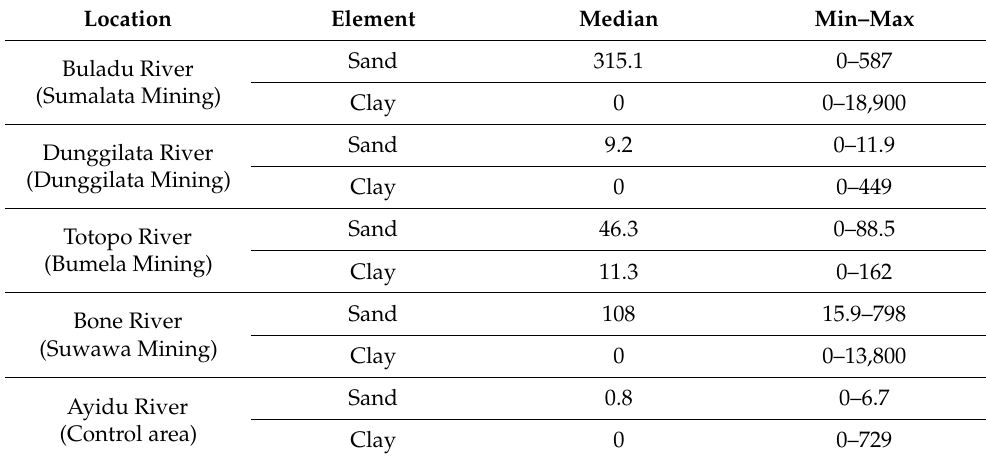
Table 3. Concentration of As ( µ g/g) in river sediment sample from ASGM and control area.